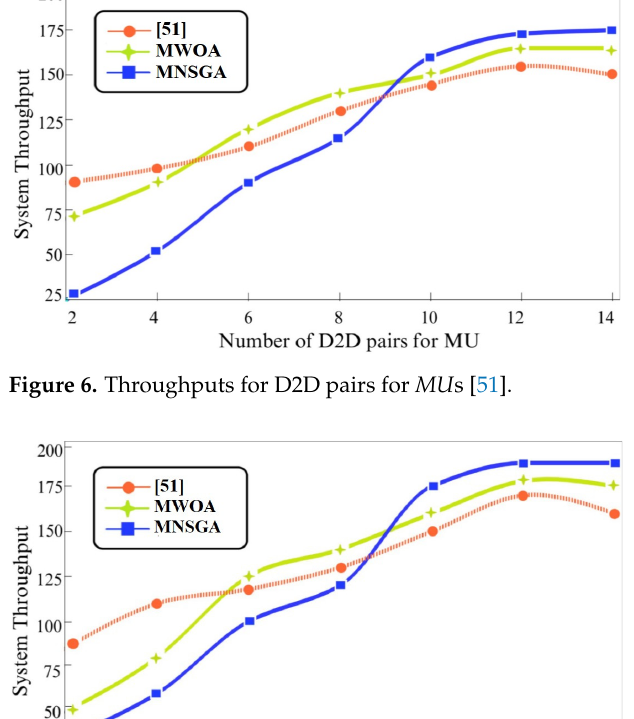
Figure 8. Overall throughputs for D2D pairs. 5.3. Throughput Analysis for Various Distances Throughput values for various distances between D2D pairs are shown in Figures 9–11 for MU s, DU s, and overall users. Once again, the proposed MNSGA scheme outperforms the MWOA method. For all techniques, it is seen that the system throughput becomes lower as the length between D2D pairs increases. This is due to the fact that as the space in the middle of D2D pairs grows, the strength of the desired signal weakens, resulting in a reduction in system throughput. In Figure 9, the system throughputs of MNSGA and MWOA are compared with respect to the distance be- tween D2D pairs for MU s. In Figure 10, the system throughputs of MNSGA and MWOA are compared with respect to the distance between D2D pairs for DU s.